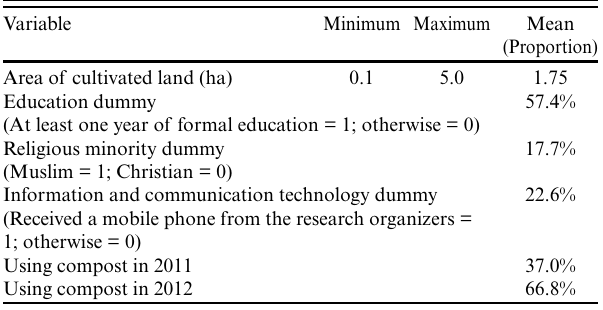
Table 1 . Description of the sample.